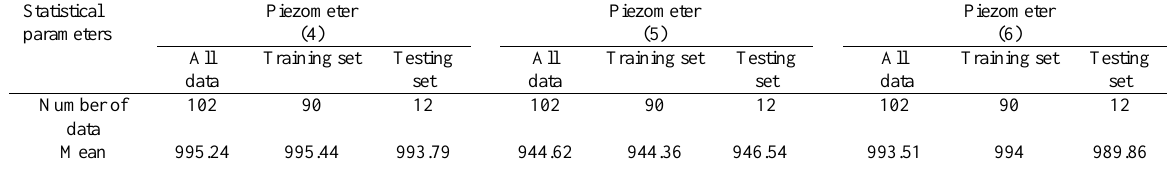
Table 3. Statistics analysis for training, testing and all data